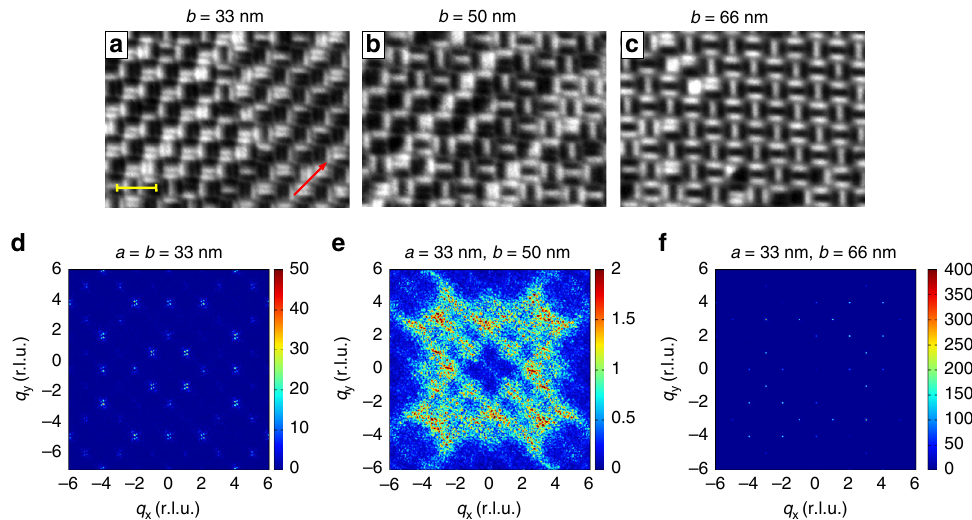
Fig. 4 Experimental low-temperature observations. a – c XMCD images of equilibrium con fi gurations of the dipolar trident lattice with various lattice spacings ( a = 33 nm = const, b = 33, 50, and 66 nm) recorded at T = 150 K (blocking temperature T B = 160 K). The red arrow indicates the direction the X-ray propagation vector. The yellow scale bar indicates a length of ~600 nm. d – f Magnetic scattering patterns of moment con fi gurations achieved in dipolar trident lattices with lattice parameters d a = 33 nm and b = 33 nm, e a = 33 nm and b = 50 nm, and f a = 33 nm and b = 66 nm, following thermal annealing. While long-range order with relatively sharp peaks is seen for b = 33 nm and b = 66 nm, the diffuse patterns for b = 50 nm indicate highly disordered moment con fi gurations with short-range